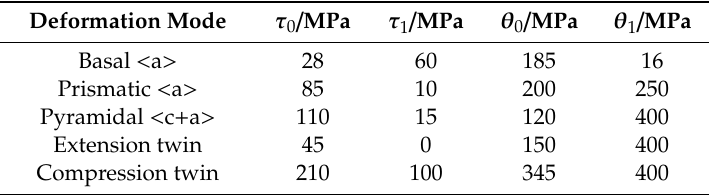
Table 2. Hardening parameters of each slip and twinning system in the simulation of Mg alloy under monotonic loading.